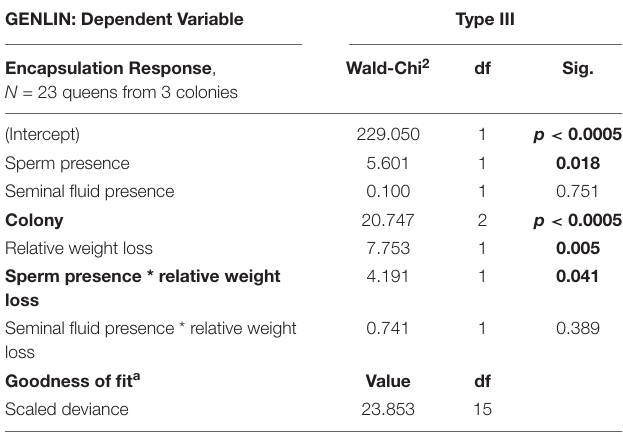
TABLE 2 | For queens of Atta colombica that had survived inseminations involving sperm ( N = 5 for both full ejaculates and sperm only ejaculates, pooled here for analysis to N = 10), encapsulation responses decreased, the more weight queens had lost during the experiment, as indicated by the significant interaction term between sperm presence and relative weight loss ( Figure 3 ) in addition to a significant main effect of sperm presence. Survivors of inseminations with seminal fluid only ( N = 4) or one of the control treatments ( N = 5 for Hayes saline or N = 4 for sham controls—all pooled here to N = 13), showed no significant interaction with weight loss ( Figure 3 ). The encapsulation response also differed significantly across the three colonies from which queens were